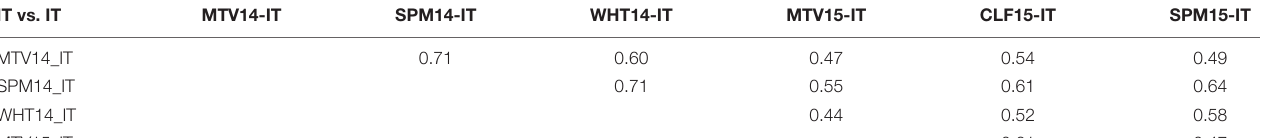
TABLE 2 | Pearson’s correlation coefficients for infection type (IT) and disease severity (SEV) to Puccinia striiformis f. sp. tritici at the adult-plant stages in six environments. IT vs. IT MTV14-IT SPM14-IT WHT14-IT MTV15-IT CLF15-IT